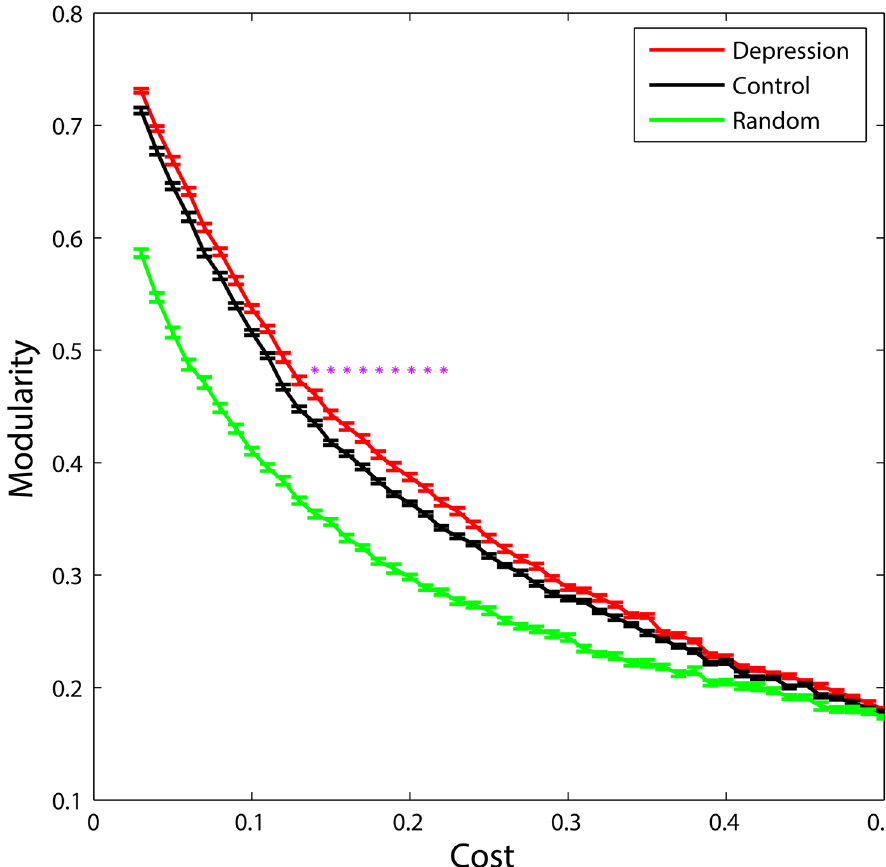
Fig 2. Modularity of functional brain networks. Functional brain networks of MDD patients (red) and healthy controls (black) showed larger modularity than random networks (green) at the whole range of 0.03~0.37. Additionally, increased modularity in MDD patients was observed over the range of 0.14~0.22 ( p < 0.05). Error bars corresponded to standard error of the mean. Purple stars indicated where the difference between MDD patients and healthy controls was significant ( p <